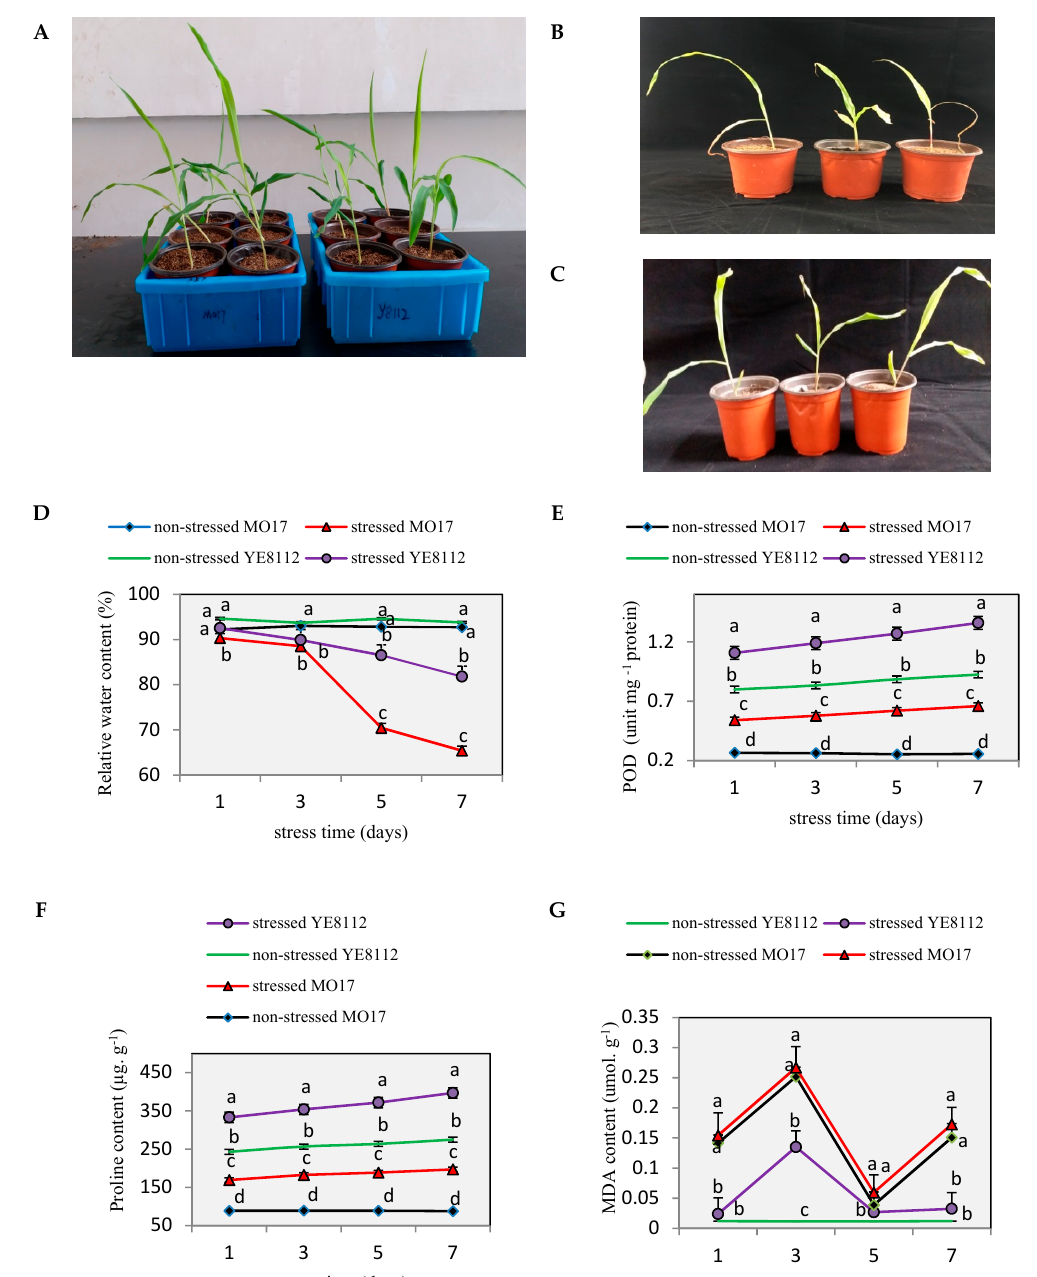
Figure 1. Phenotypic ( A – C ) and physiological ( D – G ) responses of two maize inbred lines to drought stress. Phenotypic displays presented here are for three-leaf-stage seedlings after 7 days of moisture deficit treatment. ( A ) MO17 and YE8112 inbred lines under non-stressed (water-sufficient) conditions; ( B ) sensitive line MO17 drought stressed; ( C ) tolerant line YE8112 drought stressed; ( D – G ) physiological changes were measured in leaf tissues at different stress exposure periods/time points (1, 3, 5, and 7 days); ( D ) leaf relative water content, ( E ) peroxidase (POD) enzyme activity, ( F ) proline content and ( G ) level of lipid peroxidation (MDA (malondialdehyde) content). Data are presented as the mean ± standard error ( n = 3). Different letters above line graphs show significant difference among treatments at a given day of treatment ( p ≤